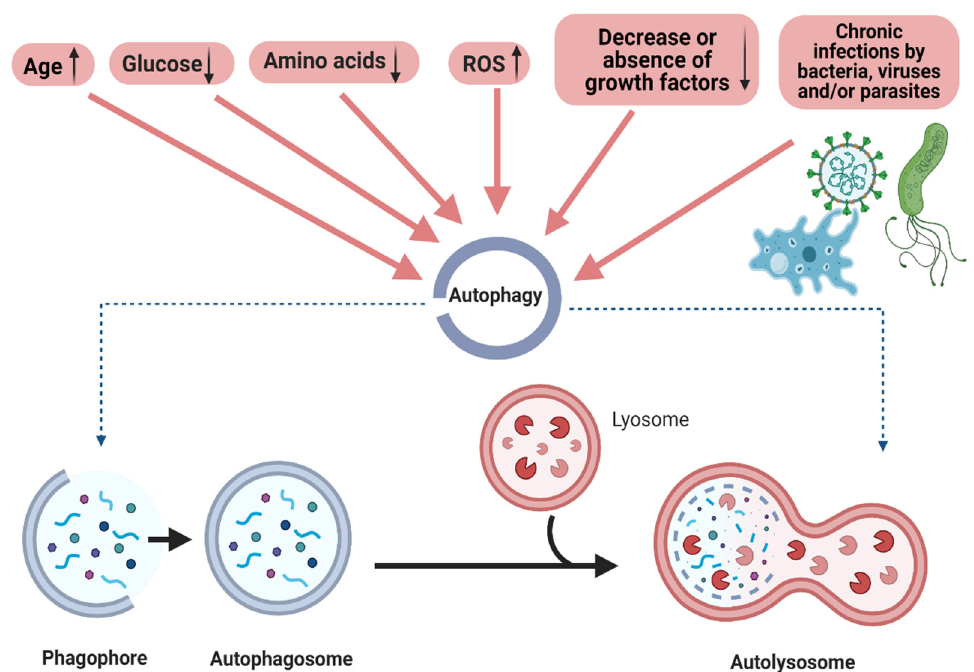
Figure 6. Modulator factors for autophagy. Several factors regulate autophagy. For instance, aging, glucose, and amino acids decreased, growth factor withdrawal, ROS, stress increased, and chronic infections by bacteria, viruses, or parasites “Created with BioRender.com (accessed on 1 May 2022).”